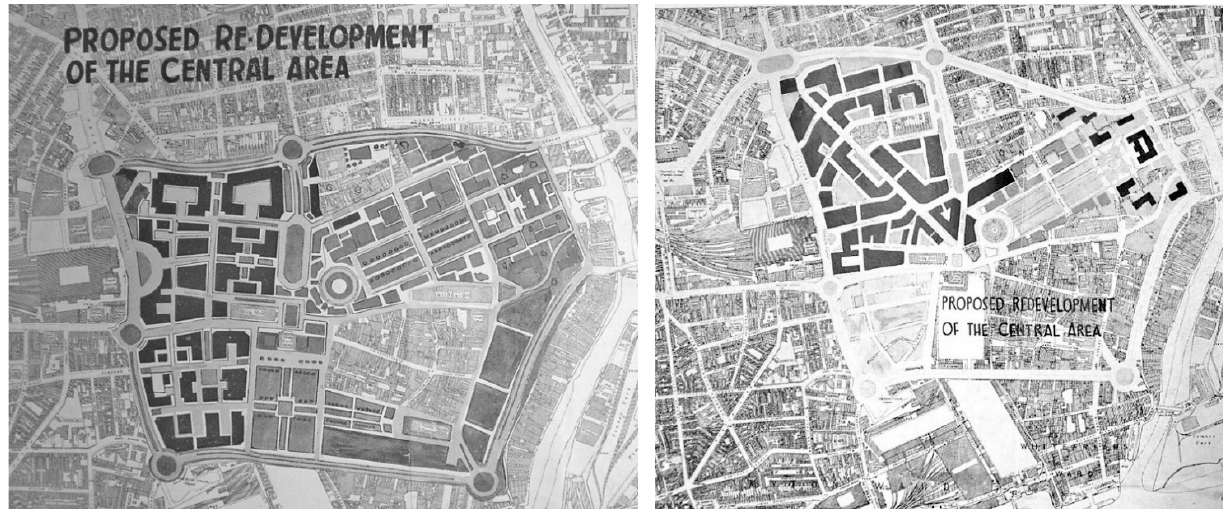
Figure 2. Competing visions of central Hull: From the City Council (left) and Chamber of Trade (right). Source: Kingston Upon Hull Chamber of Trade